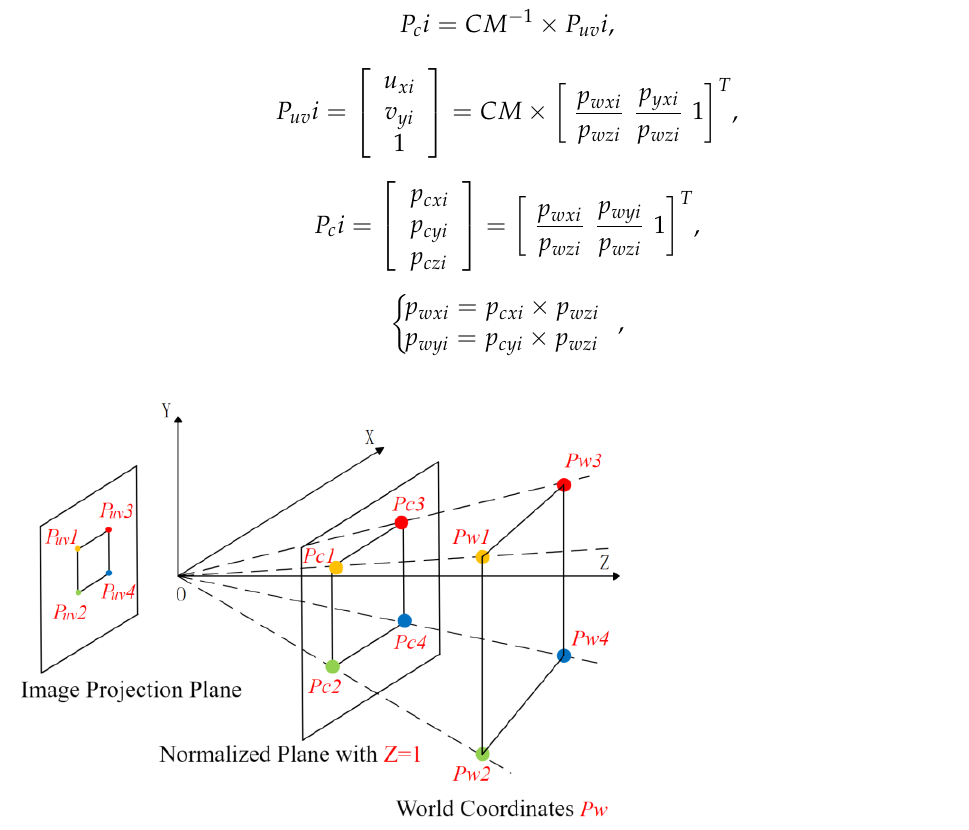
Figure 8. Diagram of 3D to 2D projection.